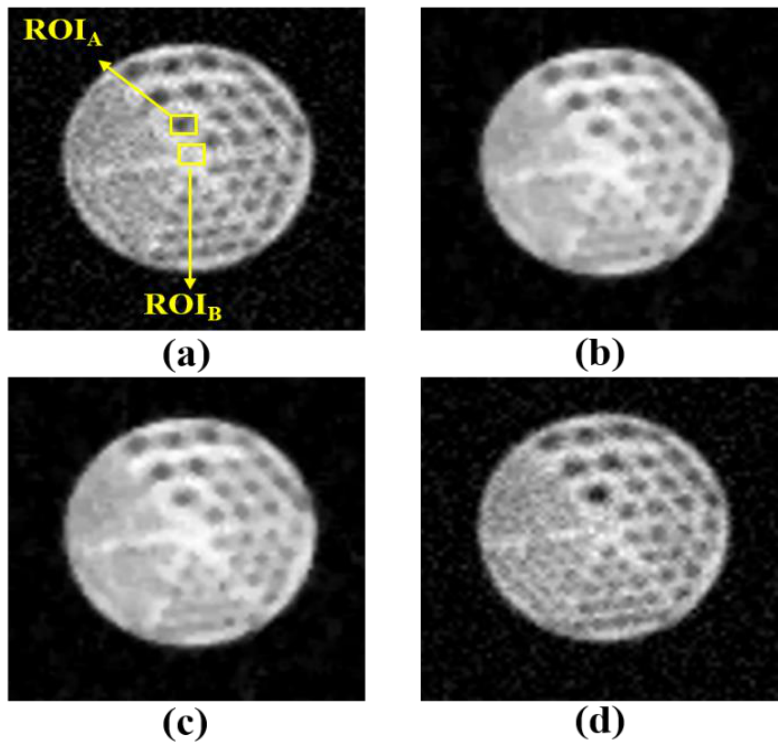
Figure 3. MR-AC Dixon-CAIPI -based PET phantom images with ( a ) noise, ( b ) Wiener filter, ( c ) median filter, and ( d ) TV algorithm. The contrast-to-noise ratio (CNR) was calculated using the ROI A and ROI B , and the coefficient of variation (COV) was calculated using the ROI A .